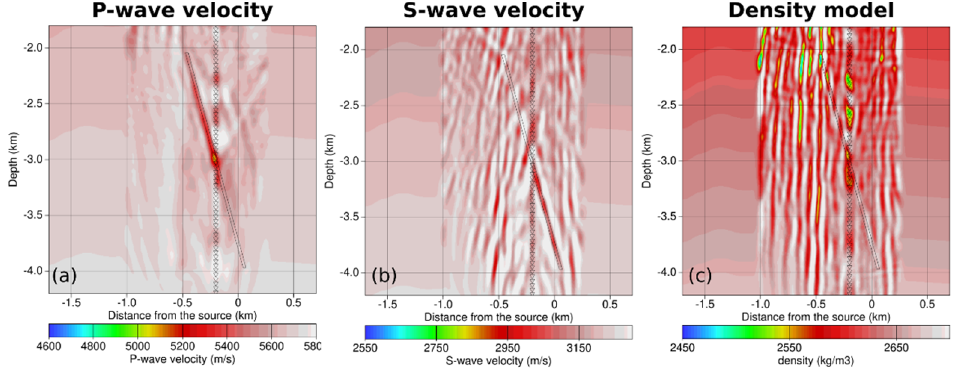
Figure 5. The physical models retrieved from FWI for one shot at zero offset. ( a ) P-wave velocity model shown for the interest area around the receivers (see the white box in Figure 2c). ( b ) and ( c ) recovered S-wave velocity and density models, respectively. The trace of the simulated fault is shown with black polygons. Table 1. Geometry data acquisition parameters used in the sensitivity study for fault detection, delineation and characterization.